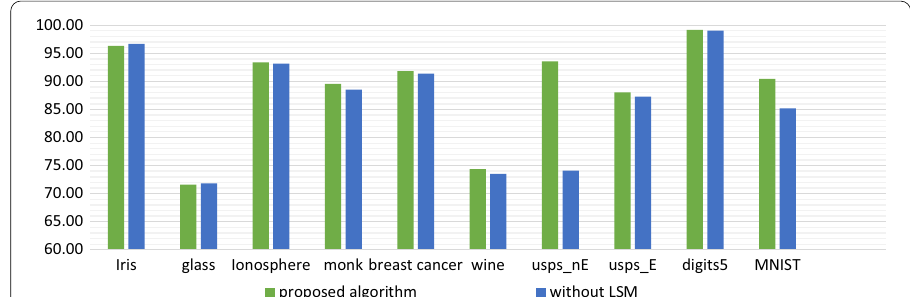
Fig. 8 Average classification accuracy of proposed method with and without LSM on evaluation datasets